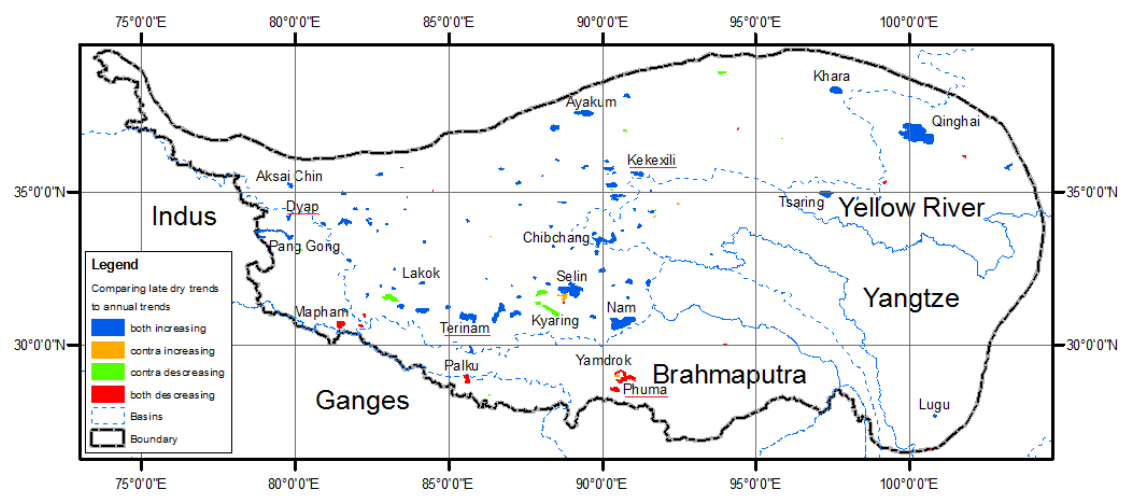
Figure 3a. Comparing late dry to annual water level trends of the Tibetan lakes between 2003 and